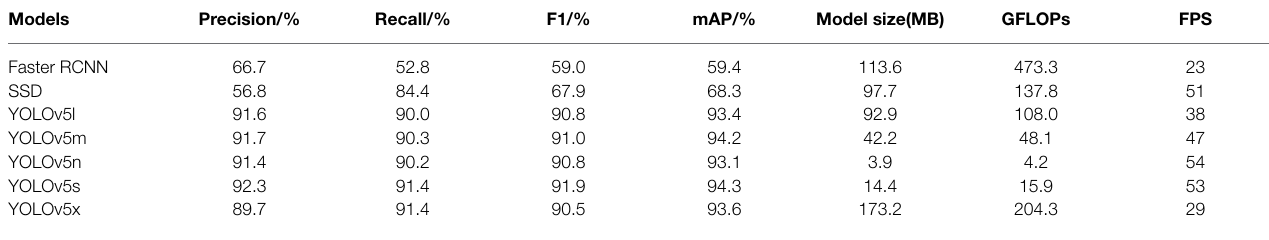
TABLE 4 | Comparison of different YOLOv5 models.